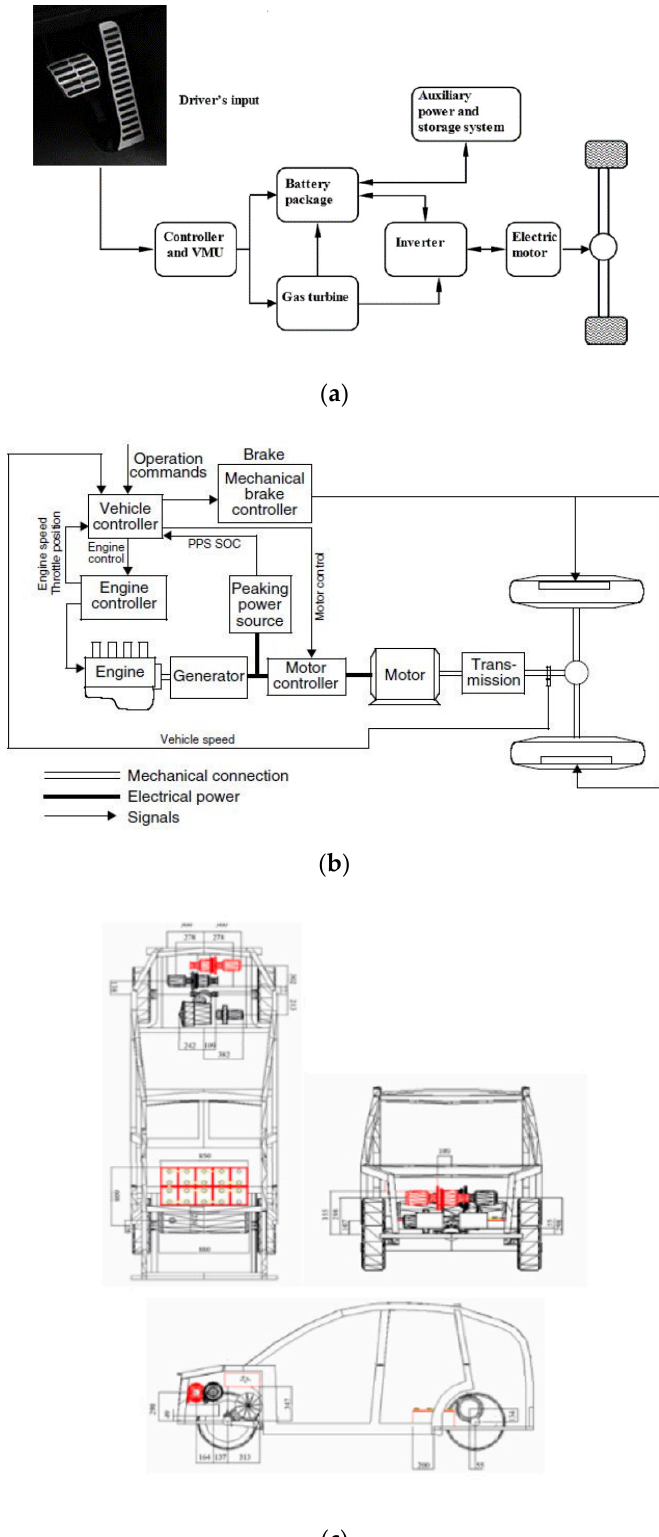
Figure 1. ( a ) Hybrid Series configuration; ( b ) Simulated car model and ( c ) possible components Figure 1. ( a )HybridSeriesconfiguration; ( b )Simulatedcarmodeland( c arrangement.